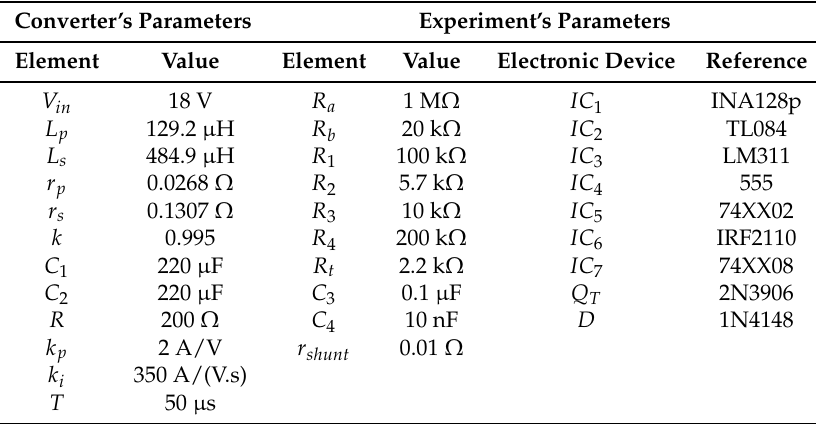
Table 2. Converter and experimental setup